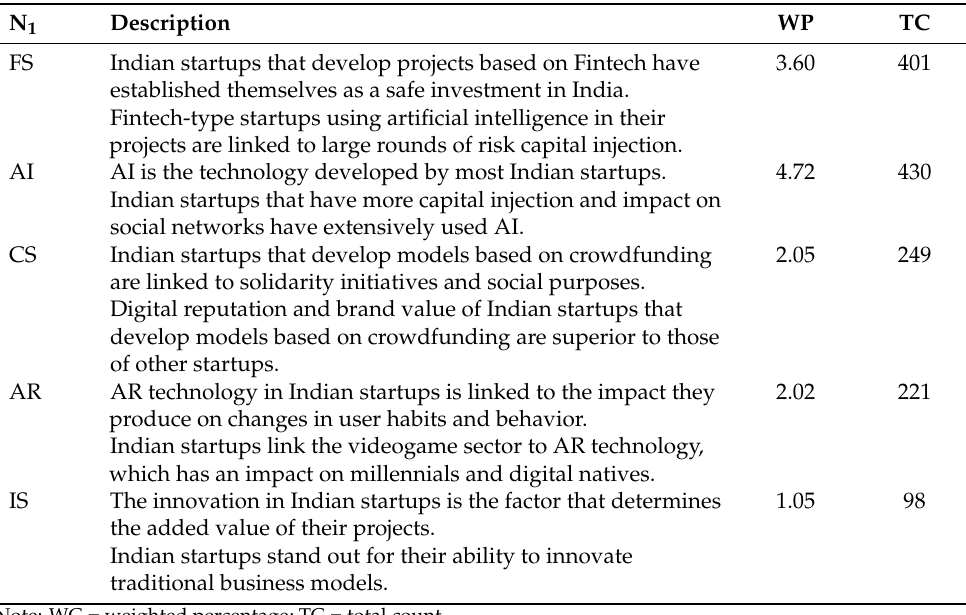
Table 4. Results for N 1 for startups positive key indicators for investors.